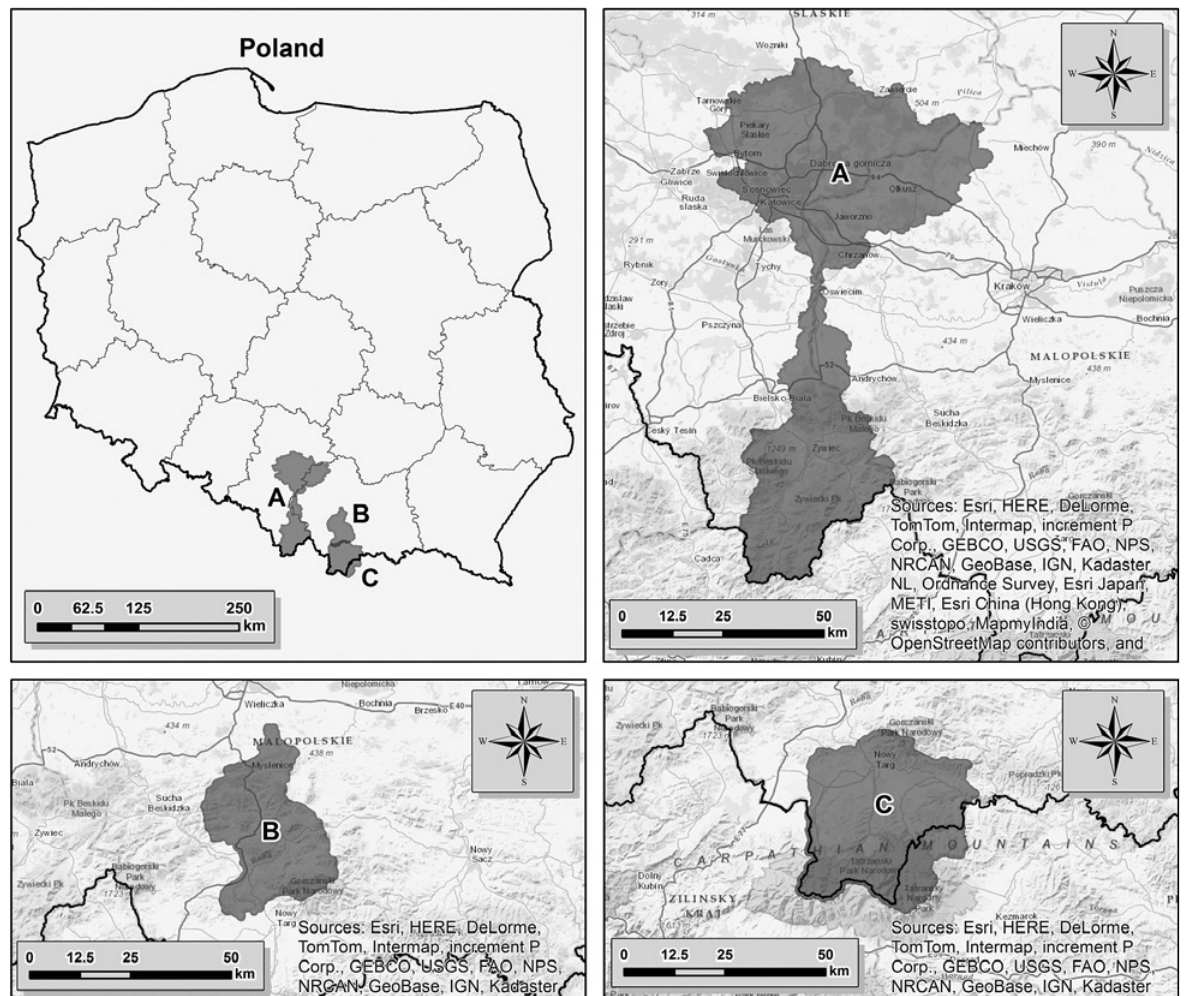
Fig. 1. The location of the analyzed water catchments in South Poland in frame of the SaLMaR project: a – dzieckowice, B – dobczyce, c – czorsztyn (partially in